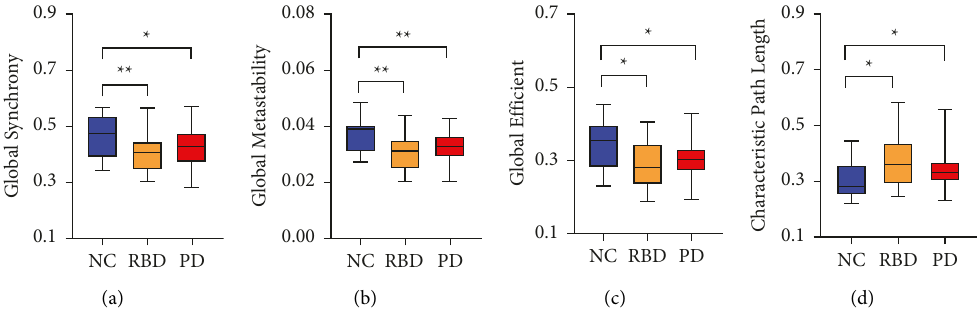
Figure 2: The differences in global neuroimaging measures between groups. (a) The difference in global synchrony between groups. (b) The difference in global metastability between groups. (c) The difference in global efficiency between groups. (d) The difference in characteristic path length between groups (